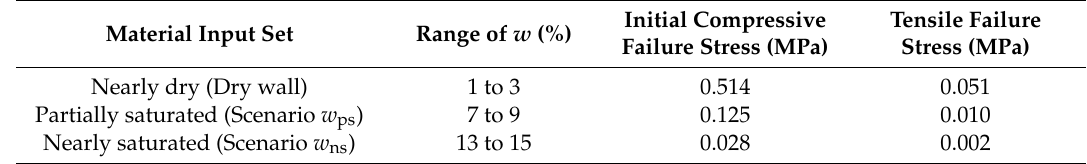
Table 1. Material input sets used in the CDP